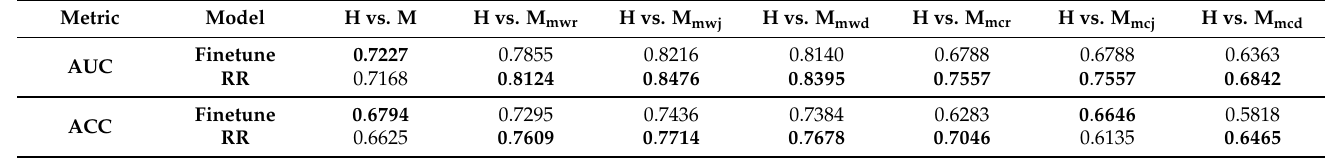
Table 2. Detailed performance of RoBERTa-Finetune and RoBERTa-RR in different classification